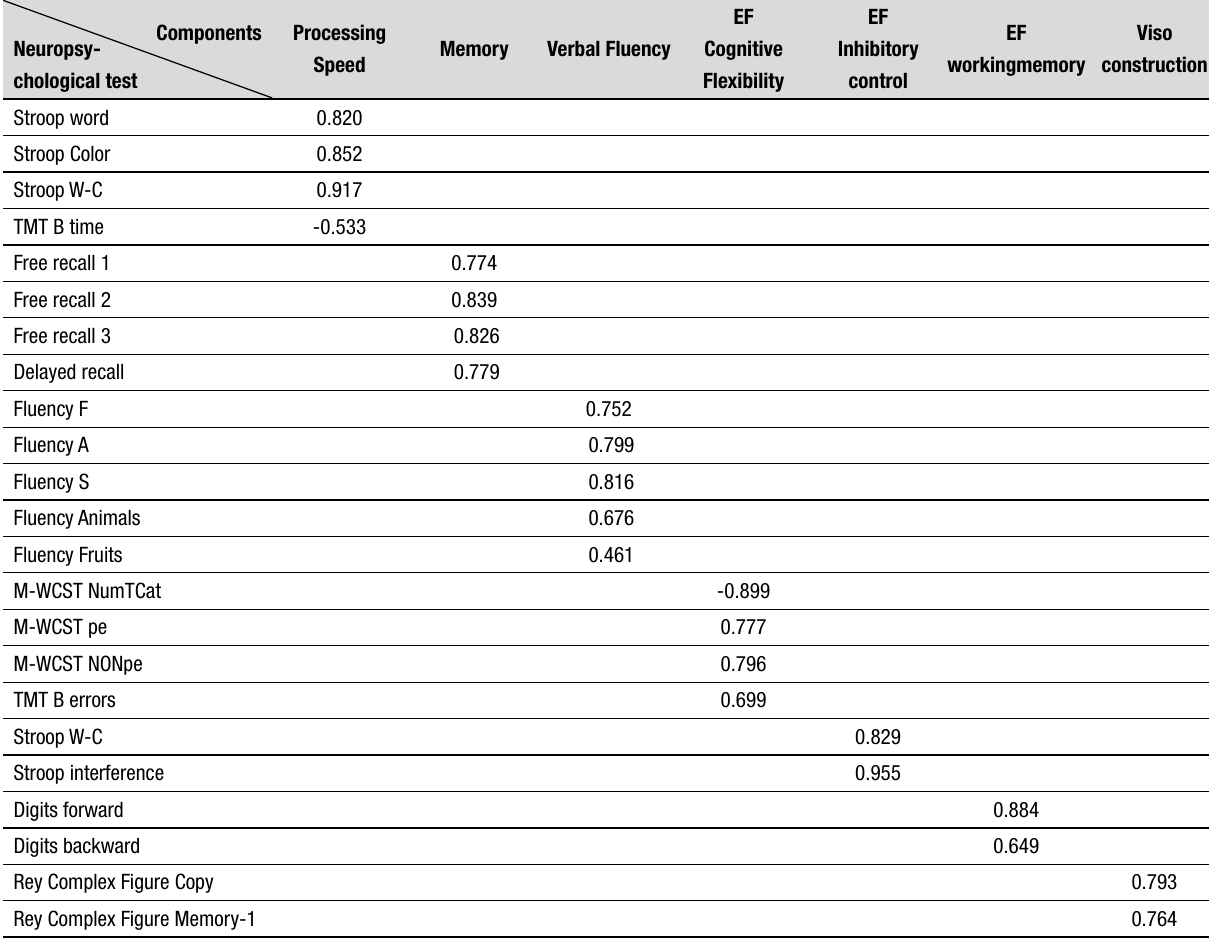
Table 2. Components loadings in extracted